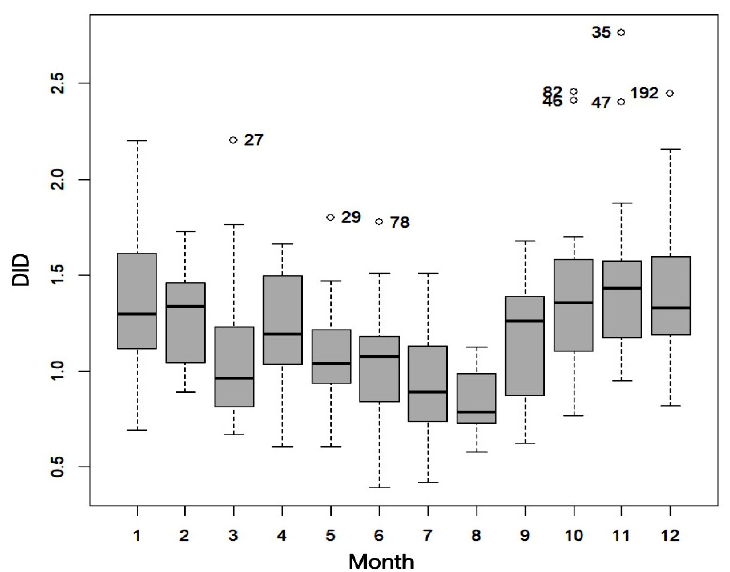
Figure 2. Monthly evolution of the defined daily dose per 1000 inhabitants per day (DID) during the period studied (2018–2021).